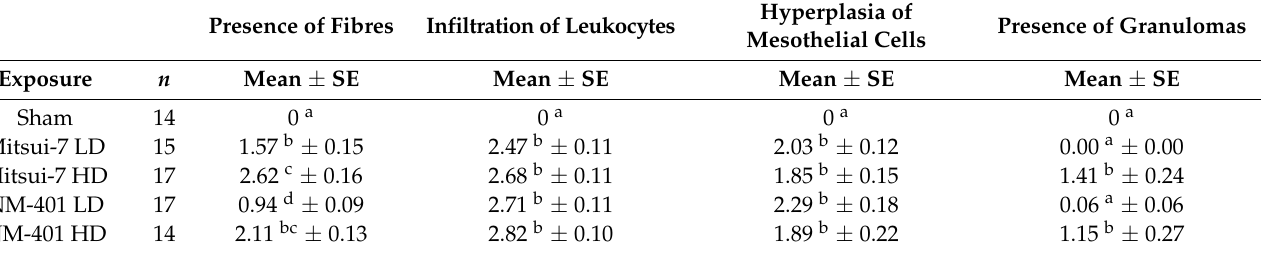
Figure 1. Pleural lesions in mice injected with MWCNT. ( a ) Thickening of parietal pleura with proliferation of fibrous tissue and multifocal infiltration of macrophages, multinucleated giant cells, plasma cells, and lymphocytes. Black arrows indicate macrophages and giant cells with visible MWCNT fibres. ( b ) Irregularly thickened visceral pleura with severe fibrosis. Asterisk indicates focal leucocyte aggregates. ( c ) Visceral pleura with proliferation of fibrous tissue and diffuse infiltration of inflammatory cells dominated by macrophages, multinucleated giant cells (arrows), and plasma cells. A granuloma with MWCNT-containing macrophages and giant cells is present (asterisk). An area with mild hyperplasia of mesothelial cells is found on the surface. ( d ) Severely thickened visceral pleura with proliferation of fibrous tissue (asterisks), mononuclear cell infiltrates, and hyperplasia of mesothelial cells (arrows). L: lung tissue, PP: parietal pleura, VP: visceral pleura, SM: skeletal muscle. Table 1. Effects of the MWCNT Mitsui-7 and NM-401 on morphological endpoints.